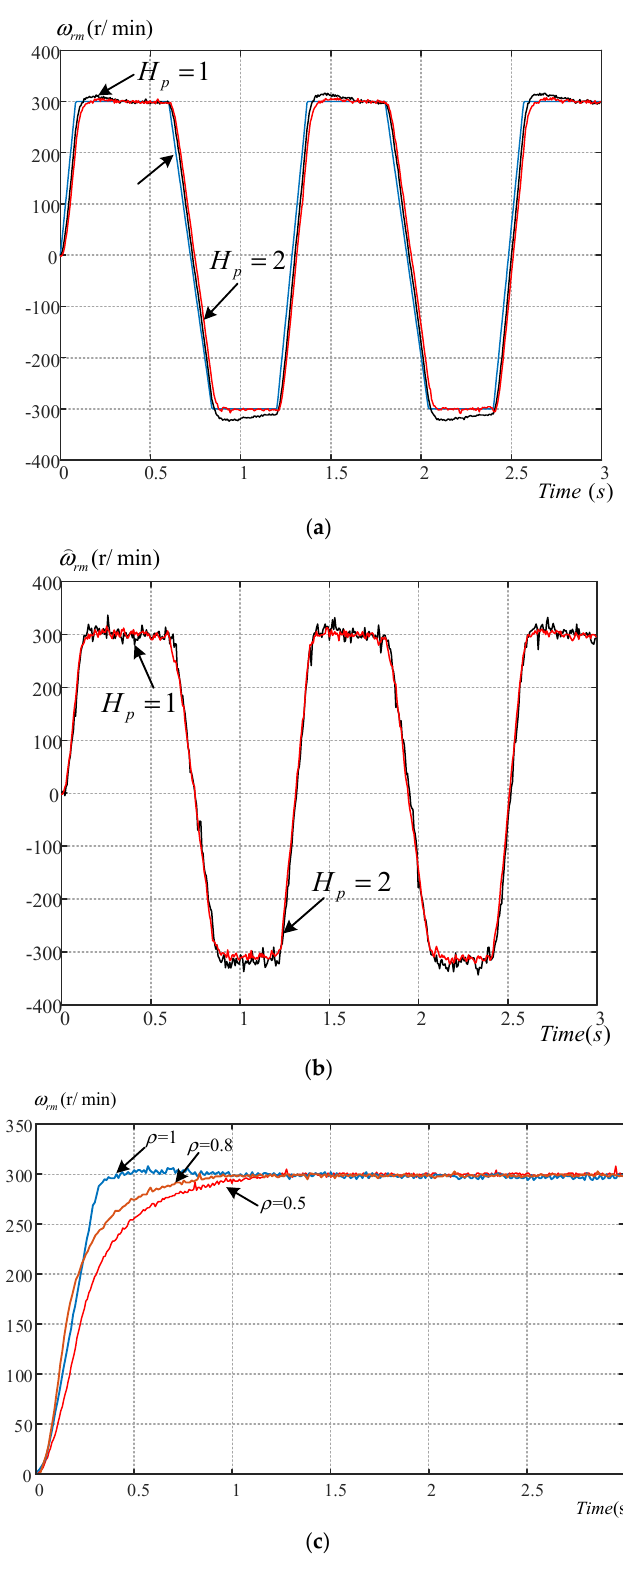
Figure 16. Measured speed tracking responses. ( a ) Trapezoidal response using an encoder, ( b ) trapezoidal response using the proposed sensorless method, and ( c ) step input using the proposed sensorless method.